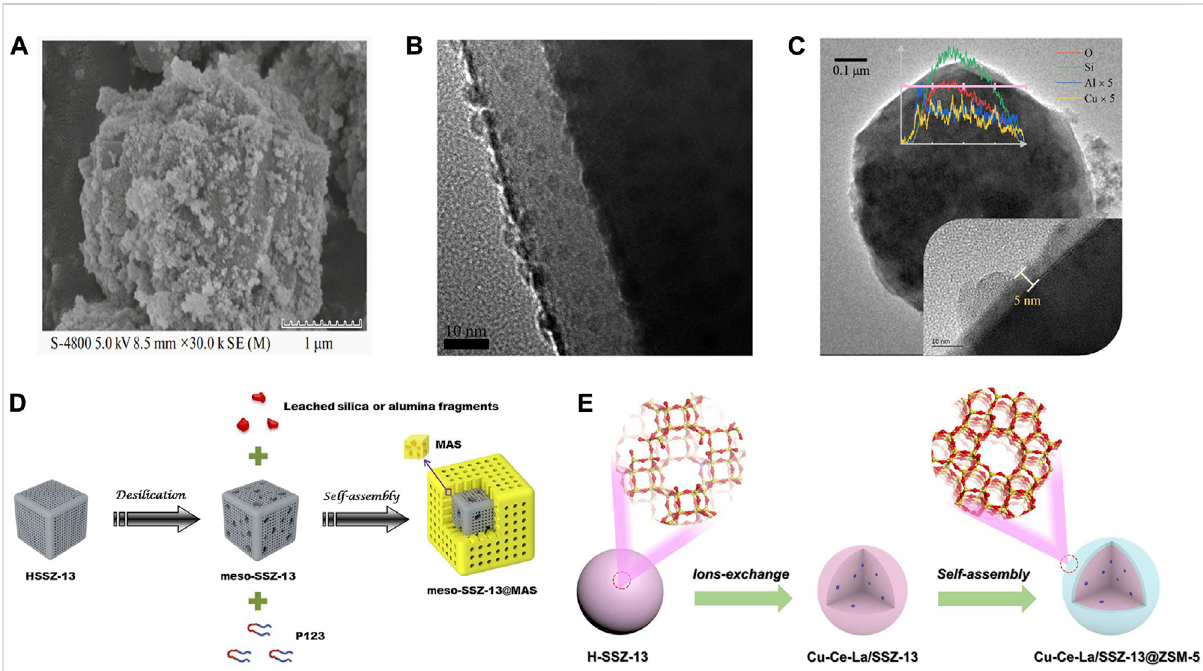
FIGURE 7 Core-shell structured Cu-SSZ-13 catalysts. (A) SEM image of Cu-SSZ-13@CeO 2 catalyst. Reproduced with permission Shi et al. (2020), Copyright 2020, Springer Publishers. (B) TEM image of SiO 2 nanolayer coating on the Cu-SSZ-13 catalyst. Reproduced with permission Tian et al. (2021), Copyright 2021, Elsevier Publishers. (C) TEM images and EDS line scanning of Al-Cu-SSZ-13. Reproduced with permission Ma et al. (2022), Copyright 2022, Elsevier Publishers. (D) Schematic representation of the preparation of meso-SSZ-13@MAS composite. Reproduced with permissionZhangetal.(2016a),Copyright2016,ElsevierPublishers. (E) SchematicrepresentationofthepreparationoftheCu-Ce-La/SSZ-13@ZSM- 5 core-shell catalyst. Reproduced with permission Chen et al. (2020b), Copyright 2020, Elsevier